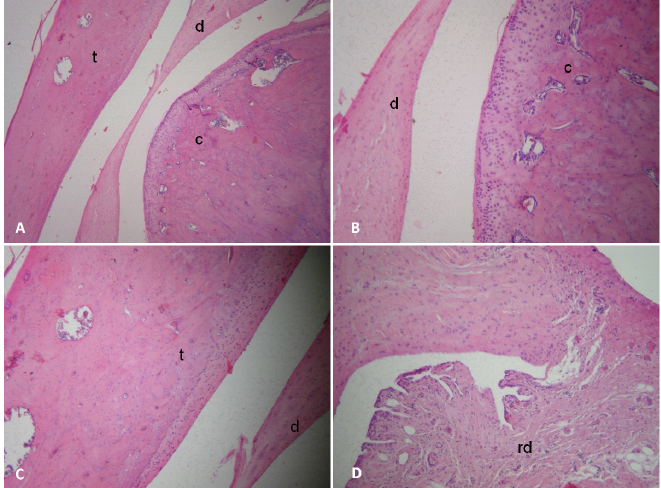
FIGURE 3 - Microscopical evaluation. A. Overall view of the TMJ, with an interposed biconcave disc. B. Articular surface of the condyle. C. Articular surface of the temporal bone. D. Aspect of the retrodiscal region (c=condyle; d=disc; t=temporal bone; rd=retrodiscal